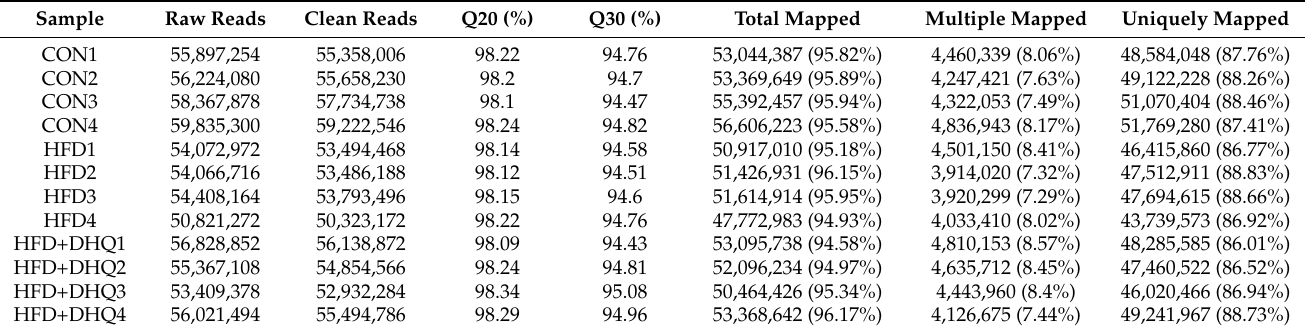
Table 2. Quality check and comparative analysis results of RNA-seq